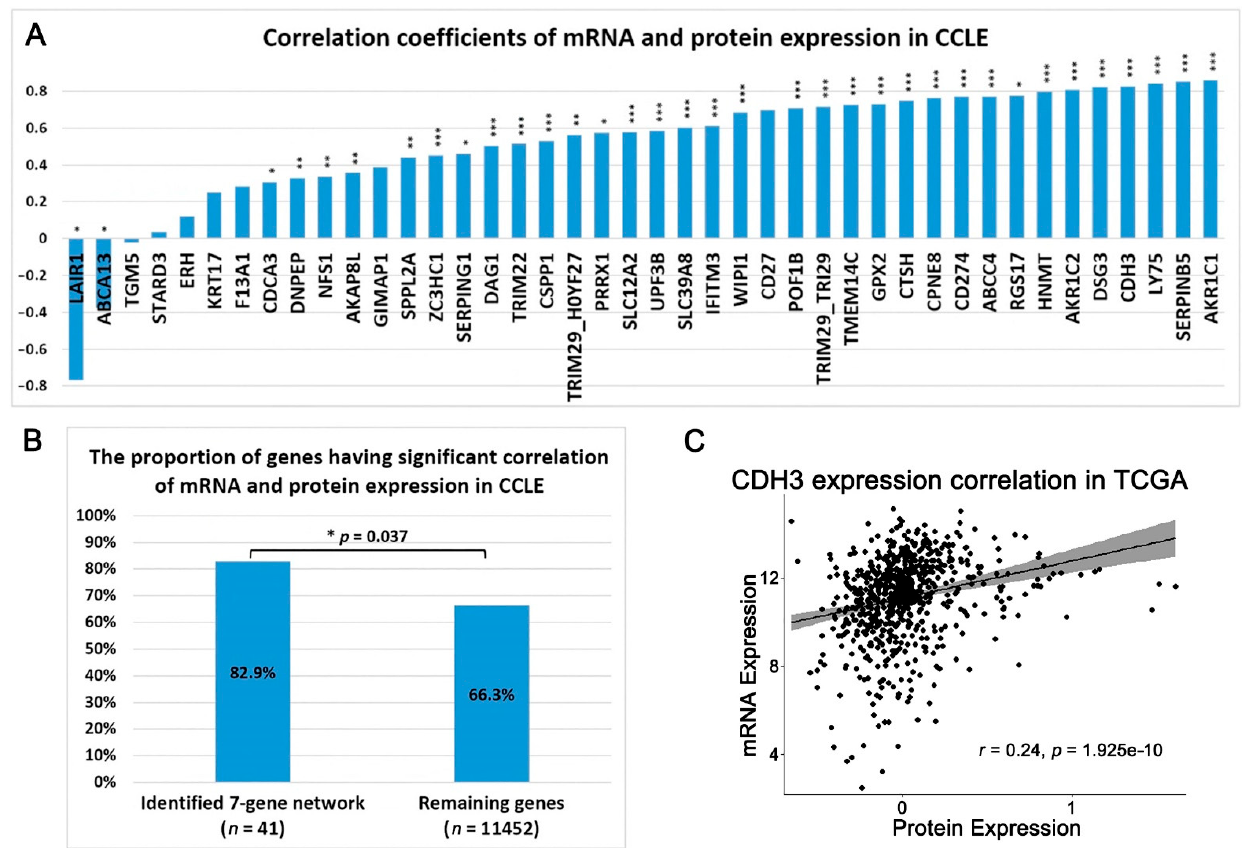
Figure 3. The correlation between mRNA and protein expression of genes in the multi-omics network (shown in Figure 1C). ( A ) The bar chart shows the correlation coefficients of mRNA and protein expression from the same gene in NSCLC cell lines. The asterisk (*) indicates the significance level (* p < 0.05, ** p < 0.01, *** p < 0.001). ( B ) The proportion of genes having a significant correlation